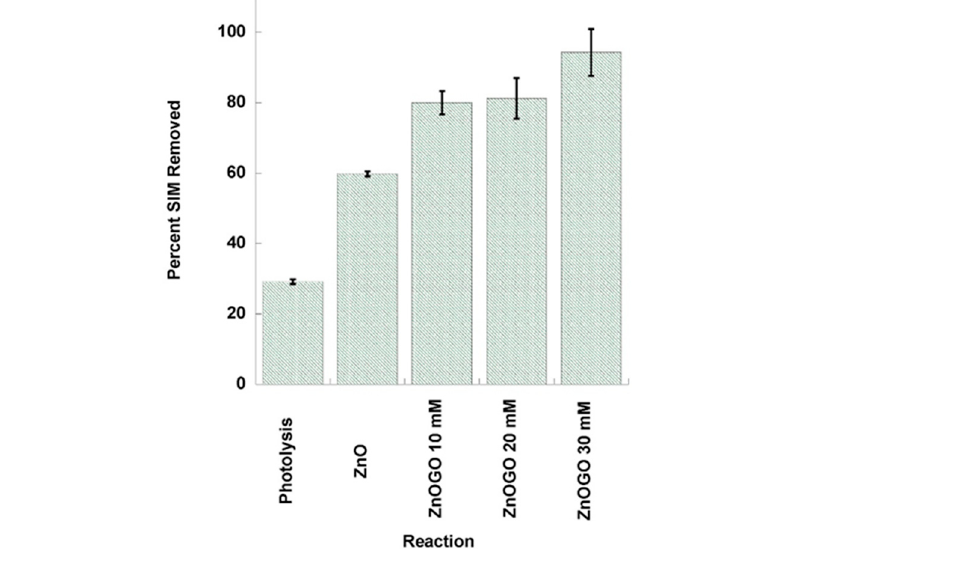
Figure 33. Percent removal of simazine from aqueous solution at pH 2 using photolysis and the various synthesized ZnO and ZnO/GO photocatalysts. Reproduced with permission from [161].